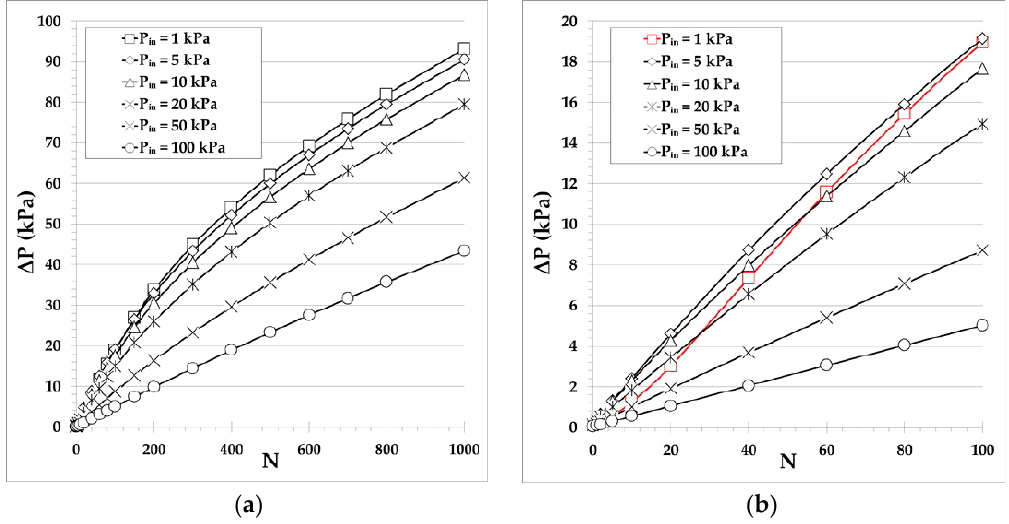
Figure 6. Maximum pressure difference (corresponding to zero net mass flow rate) of pump B with single narrow and wide microchannels of diameters d = 10 µ m and D = 100 µ m, respectively, in each stage, at various inlet pressures, versus the number of stages with ( a ) N ≤ 1000 and ( b ) N ≤ 100. The range of the rarefaction parameter in the narrow channel is ( a ) δ ≈ 0.6 − 56 and ( b ) δ ≈ 0.6 − 12 for P in = 1 kPa, and ( a ) δ ≈ 60 − 86 and ( b ) δ ≈ 60 − 62 for P in = 100 kPa. Always, δ is increasing with the inlet pressure and the number of stages.